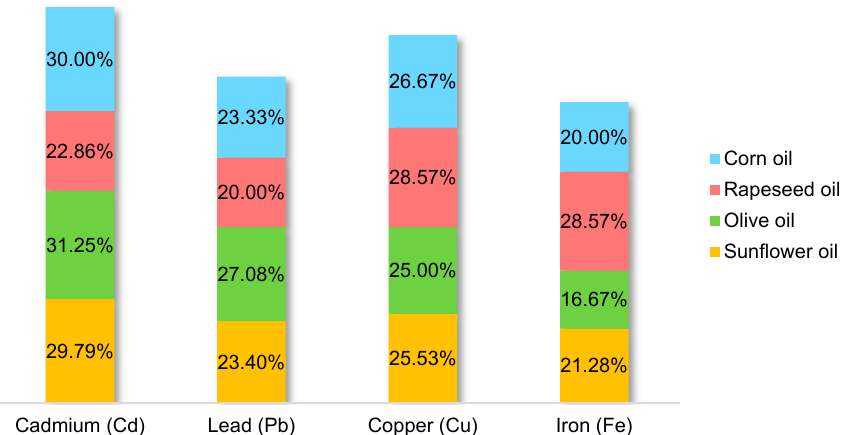
Figure 2. Study frequency of each heavy metal in each type of oil.